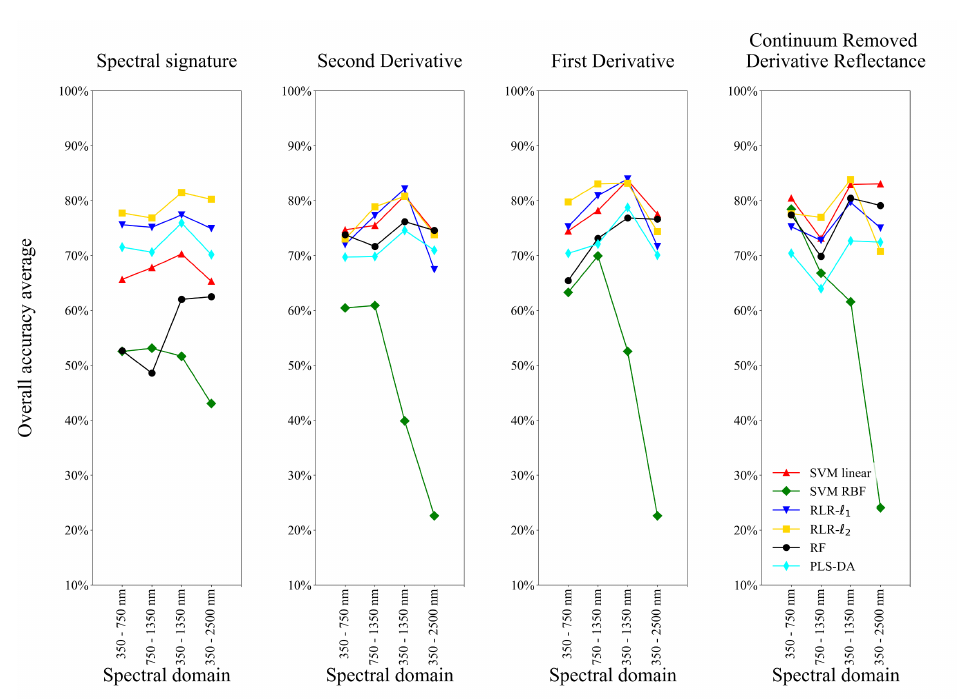
Figure 15. Vegetation type identification accuracies with the training size =